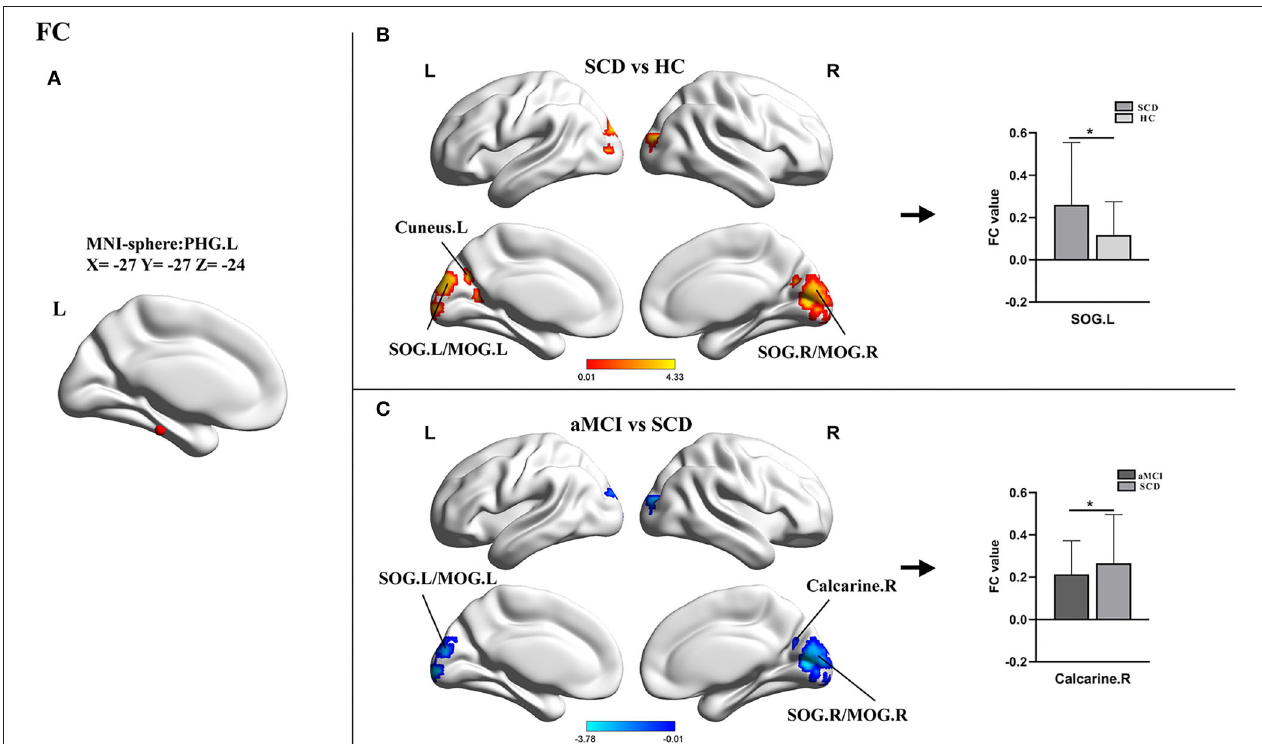
FIGURE 3 | Results of the FC analyses with the PHG.L as a seed. (A) Shows the distribution of the seed. (B,C) Show results of the significant changes among groups (one-way ANOCA, TFCE-FEW corrected, p < 0.05, the cluster size > 150 voxels; * post-hoc test, TFCE-FWE corrected P < 0.05, the cluster size > 50 voxels). FC, functional connectivity; SCD, subjective cognitive decline; aMCI, amnestic mild cognitive impairment; HC, healthy control; PHG, parahippocampal gyrus; SOG, superior occipital gyrus; MOG, middle occipital gyrus; L, left; R, right.